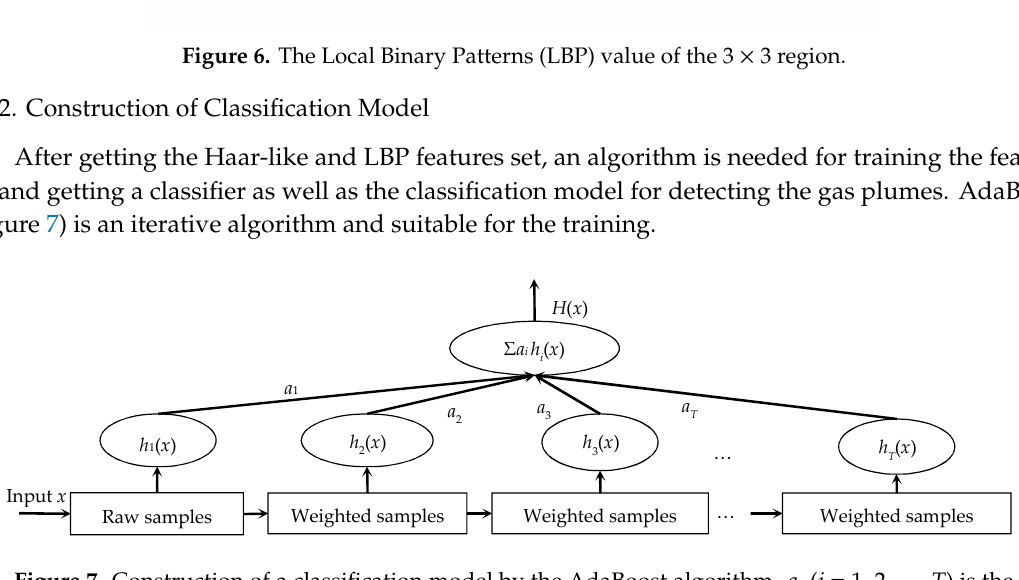
Figure 7. Construction of a classification model by the AdaBoost algorithm. a i ( i=1,2,…T ) is the weight of the h i th classifier, and x is an input vector.